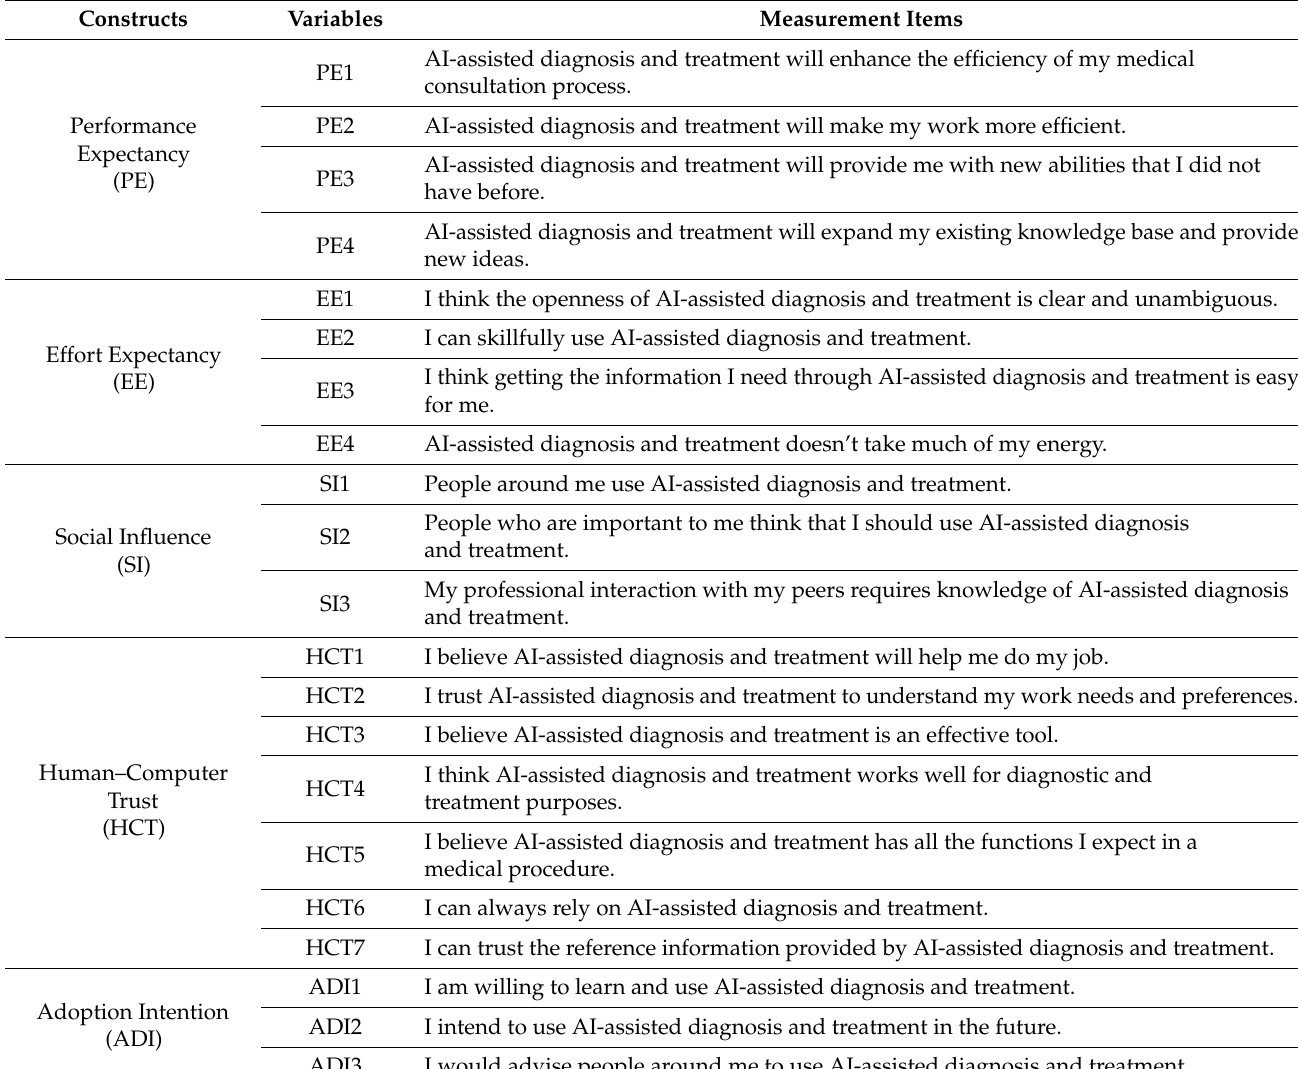
Table A1. Measurement items of